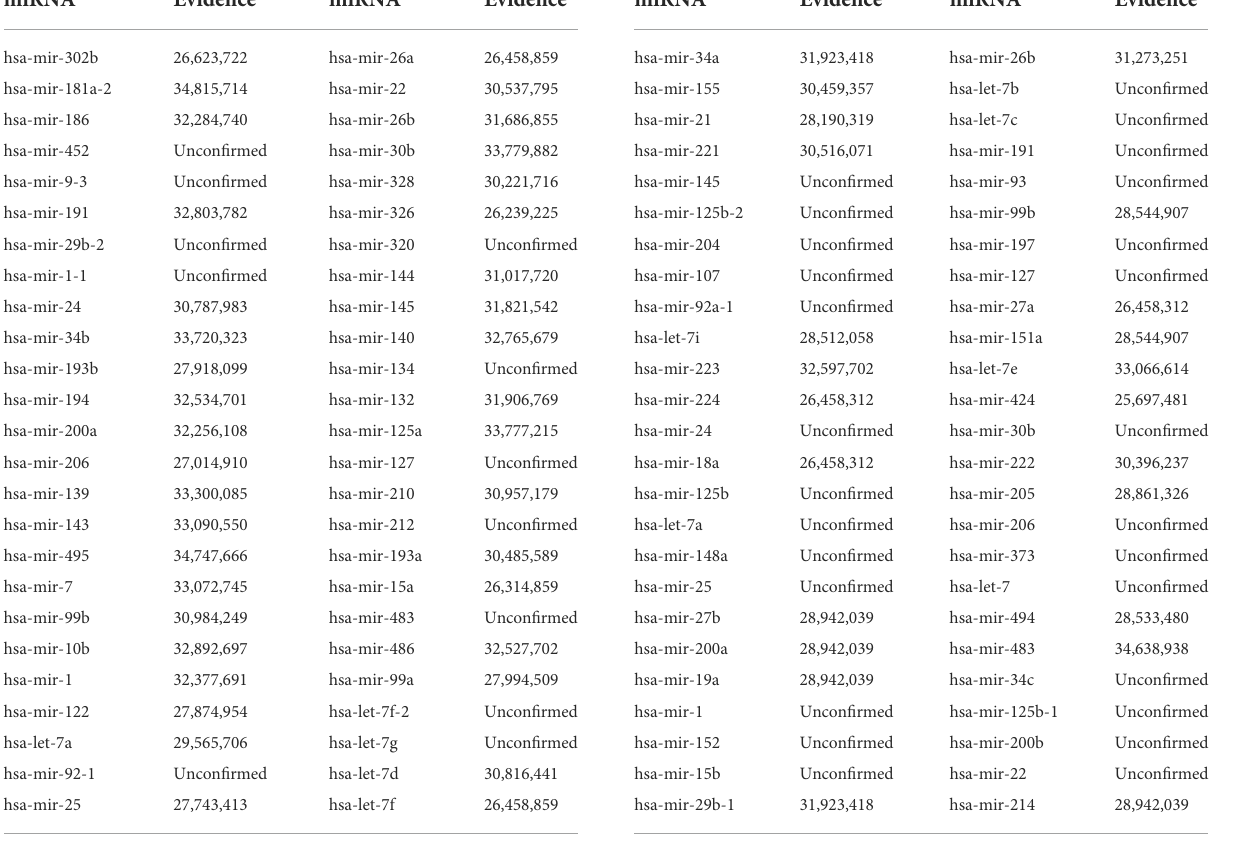
TABLE 6 Validation of the top 50 predicted miRNAs related to Cisplatin (DB00515). miRNA